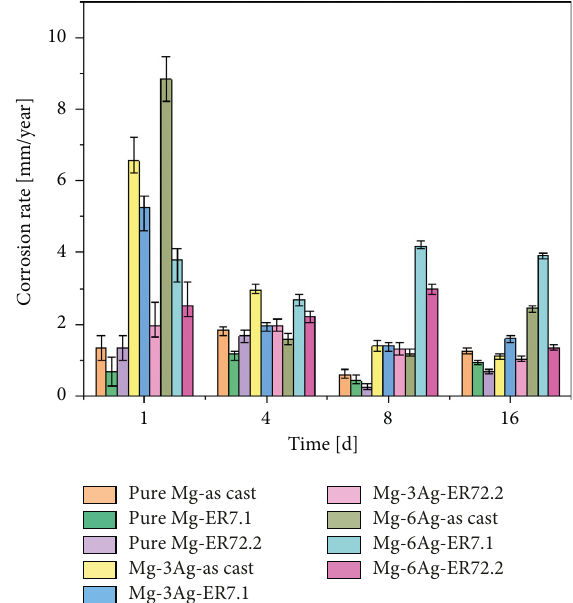
Figure 4: Corrosion rate for pure Mg and Mg-Ag alloys immersion in DMEM +10% FBS for 1, 4, 8, and 16 days (by the mass loss